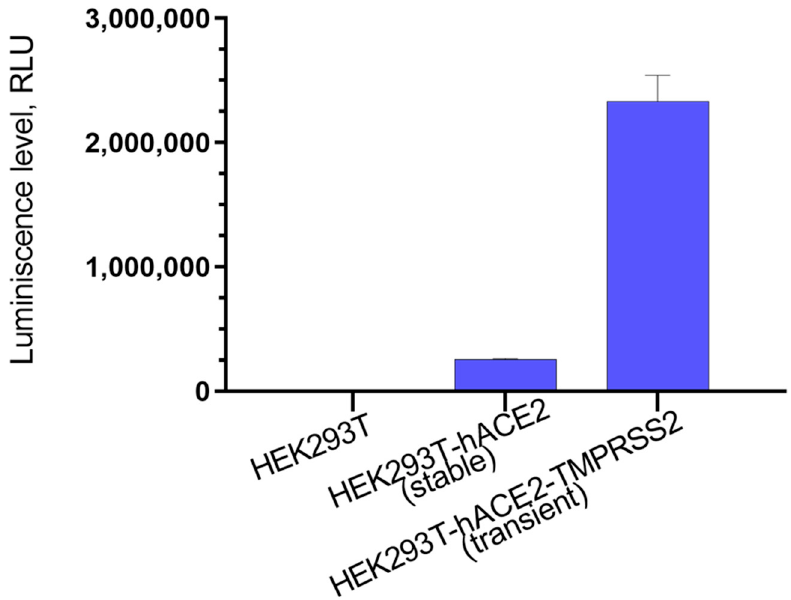
Figure 2. Infectivity of pseudoviral particles containing the SARS-CoV-2 protein on the S surface in HEK293T, HEK293T-hACE2 (stable) and HEK293T-hACE2-TMPRSS2 (transient). At 48 h post-infection, pseudovirus entry was analyzed by determining luciferase activity in cell lysates.